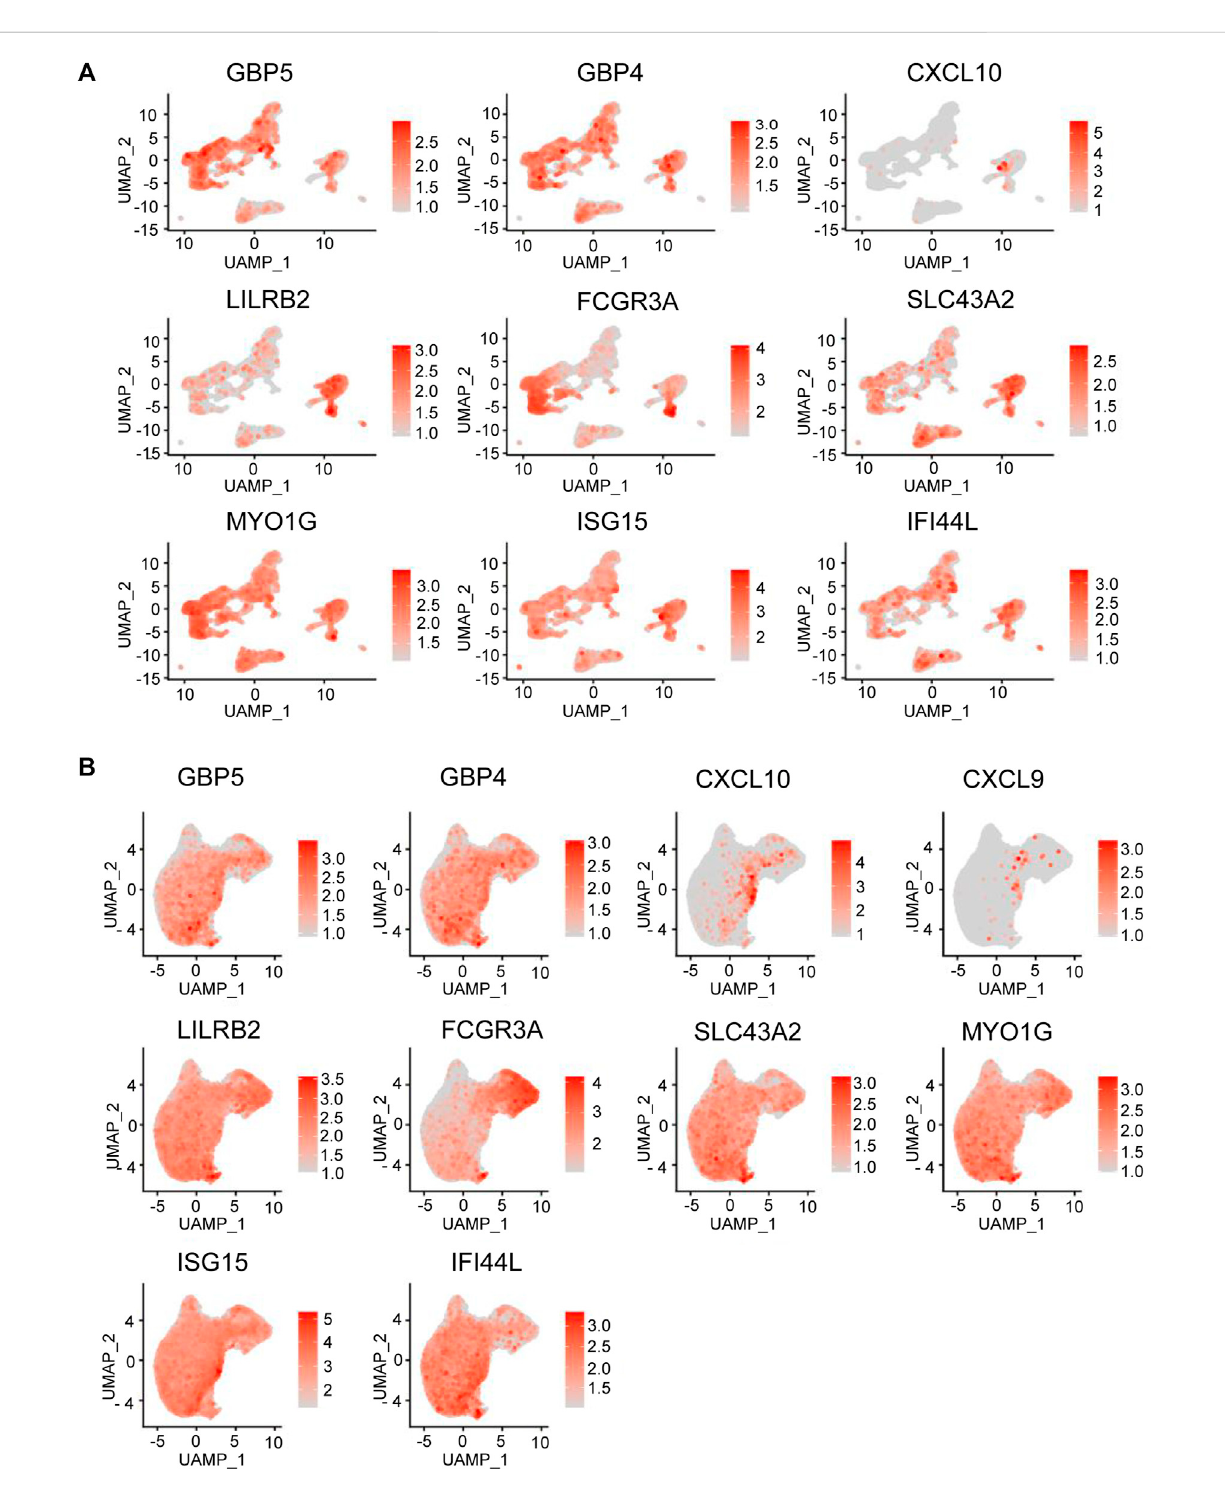
DEG expression in BD immune cell subtypes. (A) Feature plot representing the average expression level of the genes in different cell types that are highly upregulated in PBMCs from BD patients. (B) Feature plot representing the average expression level of the genes in different monocyte cell types that are highly upregulated in PMBCs from BD